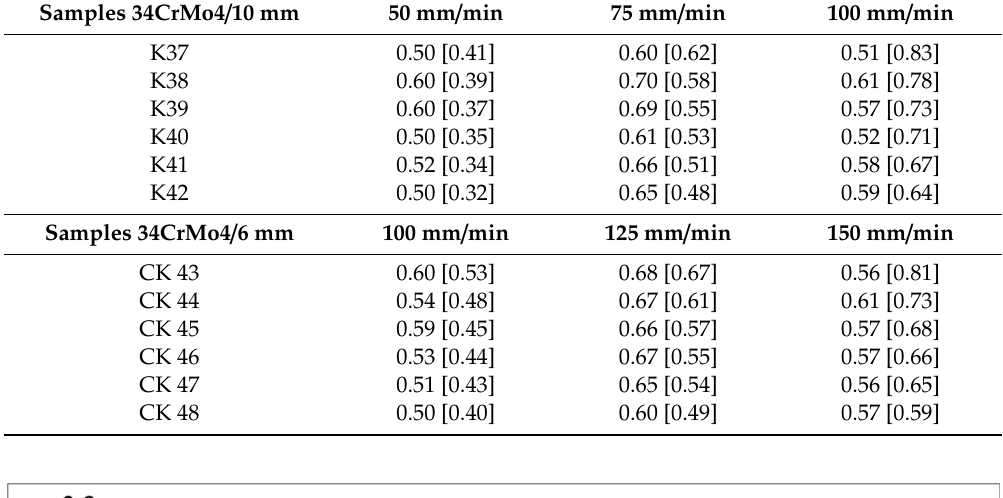
Table 4. CDFR values and the respective relative traverse speeds v R (in brackets).